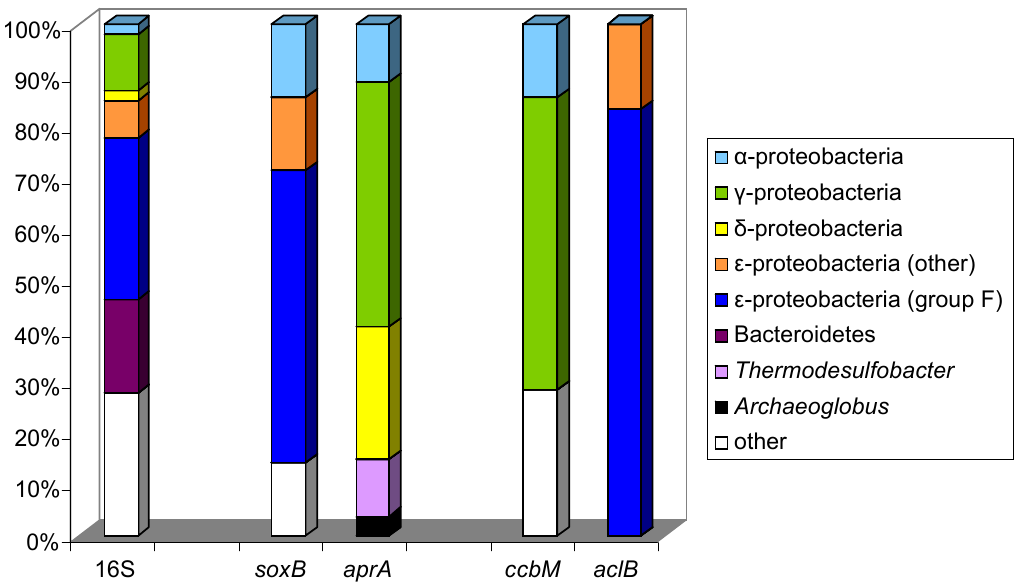
Figure 4. The microbial community composition of a hydrothermal fluid at a mussel field of Irina II at the Logatchev vent field is shown: on the left the phylogenetic groups according to 16S rRNA genes, the relative contribution of different phylogenetic groups to two sulfur oxidation pathways, the Sox-pathway ( soxB ) and the APS-pathway ( aprA ), in the middle and to two pathways of CO 2 -fixation, the reductive tricarboxylic acid cycle ( aclB ) and the Calvin cycle ( ccbM ) on the right (from [97]).